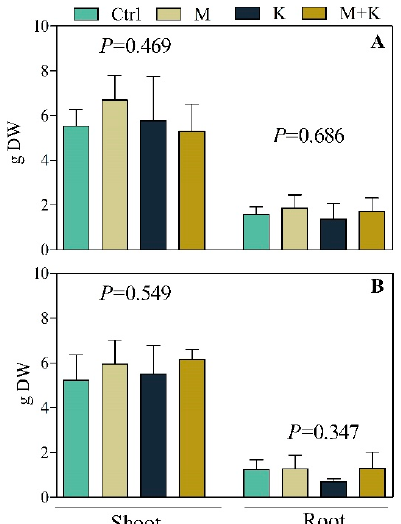
Figure 4. Dry weights (g) of shoots and roots of Populus ‘Dender ( A ) and Populus ‘Marke’ ( B ) after 6 weeks of growth in trace elements polluted soil. Ctrl (control): non-inoculated cuttings; M: Methylobacterium sp . CP3 inoculation; K: Kineococcus endophyticus CP19 inoculation; M+K: Methylobacterium sp. CP3 and Kineococcus endophyticus CP19 inoculation. Statistical significance was tested with one-way ANOVA followed by Tukey’s Multiple Comparison Test ( p ≤ 0.05).